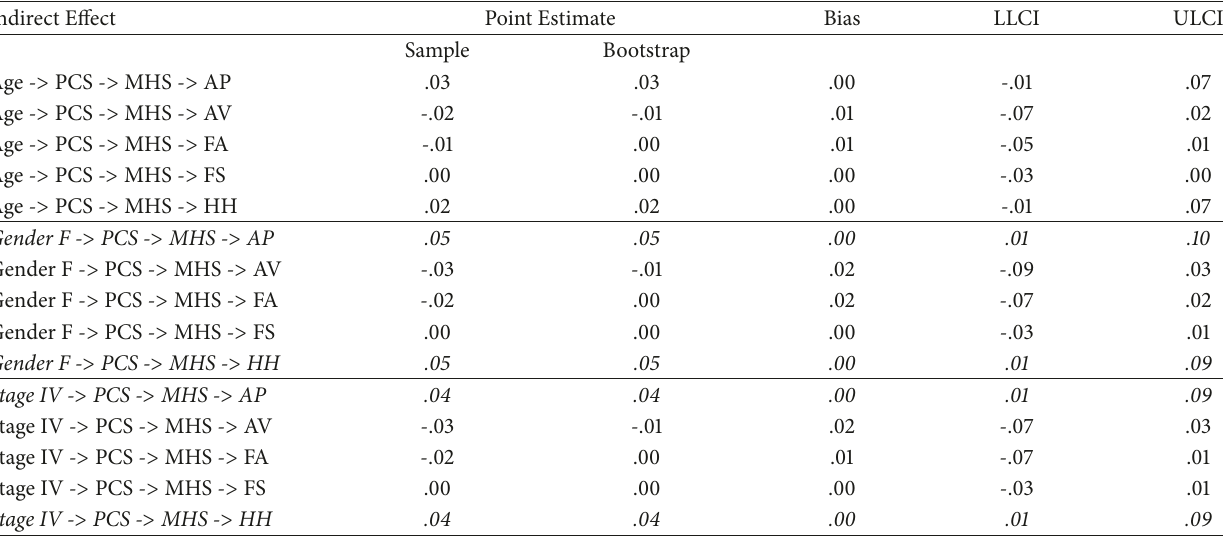
Table 4: Bootstrap tests of indirect effects identified in the structural